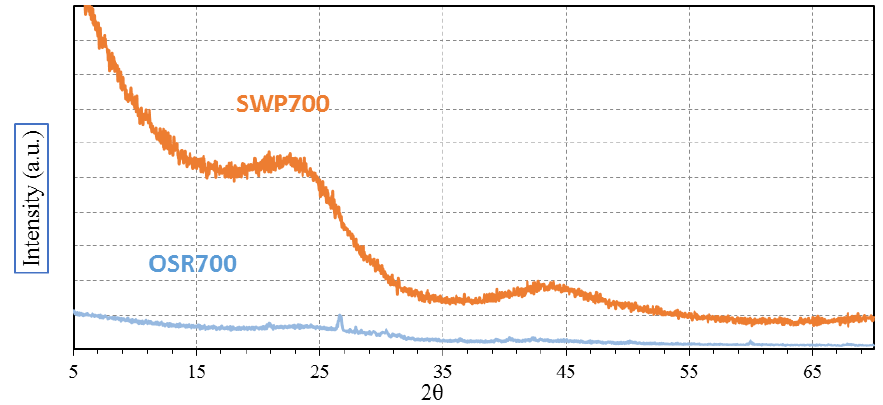
Figure 3. X-Ray diffraction (XRD), patterns of OSR700 and SWP700 biochars.